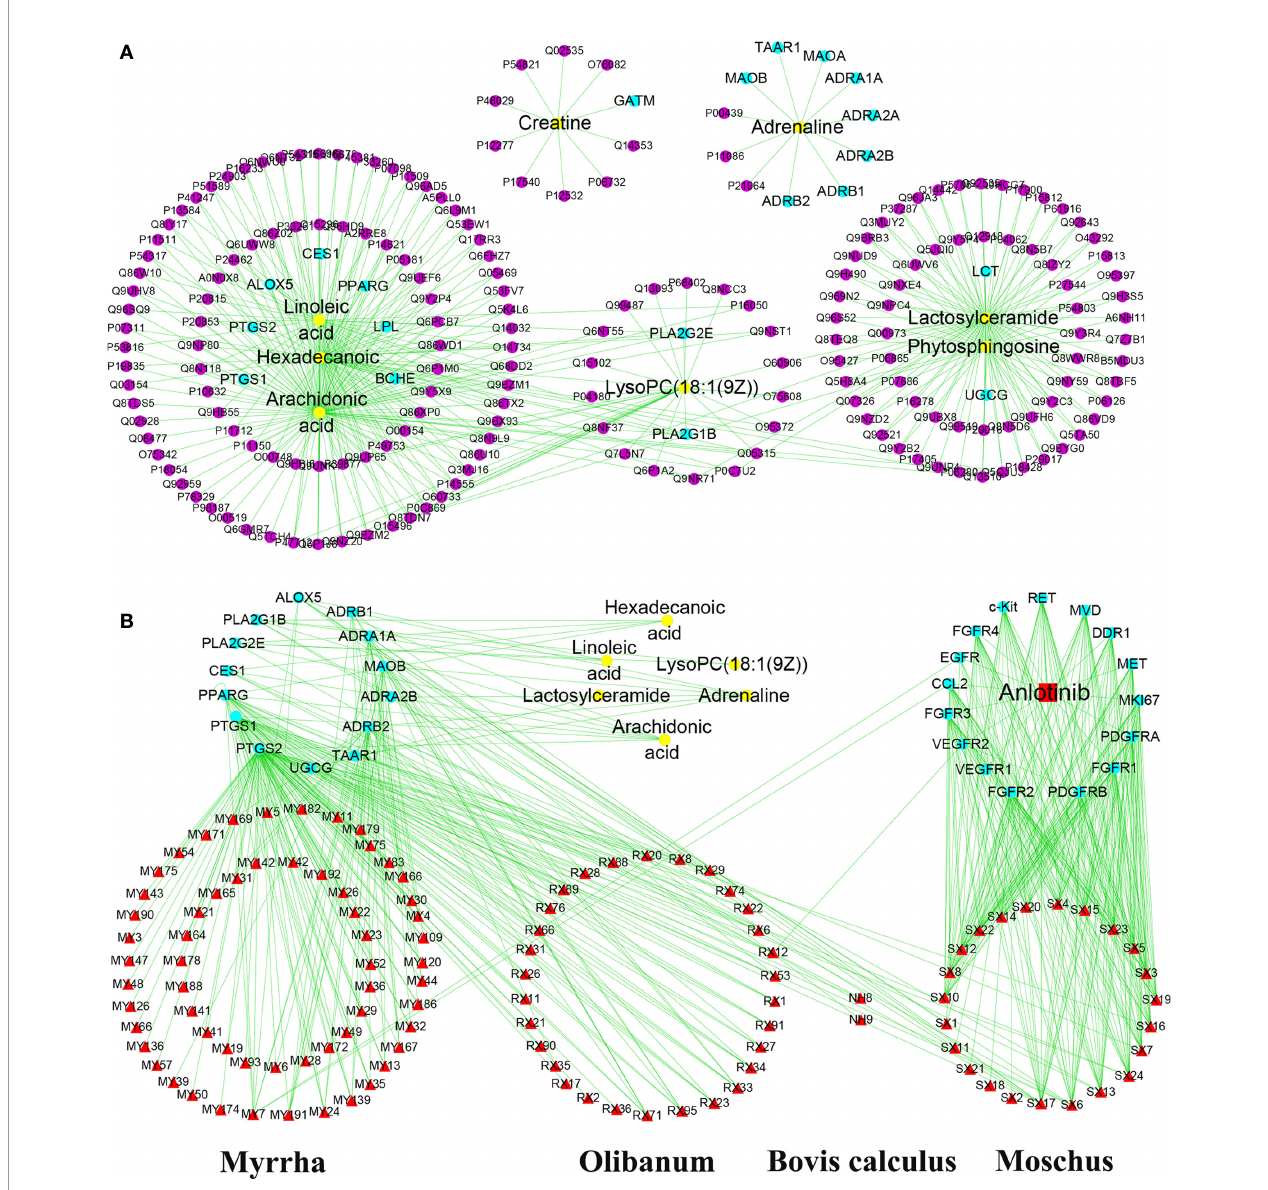
FIGURE 6 | “ Compound-target-metabolite ” interactive network construction for the effects of anlotinib and XHW in the treatment of lung cancer. (A) Direct target information regulating metabolites. (B) Anlotinib and the chemical components of Xihuang Pills coregulate the metabolite network through direct targets. The purple dots represent the targets associated with potential metabolites. The yellow dots represent potential metabolites. The red square and red triangles represent anlotinib and the chemical components of XHW,